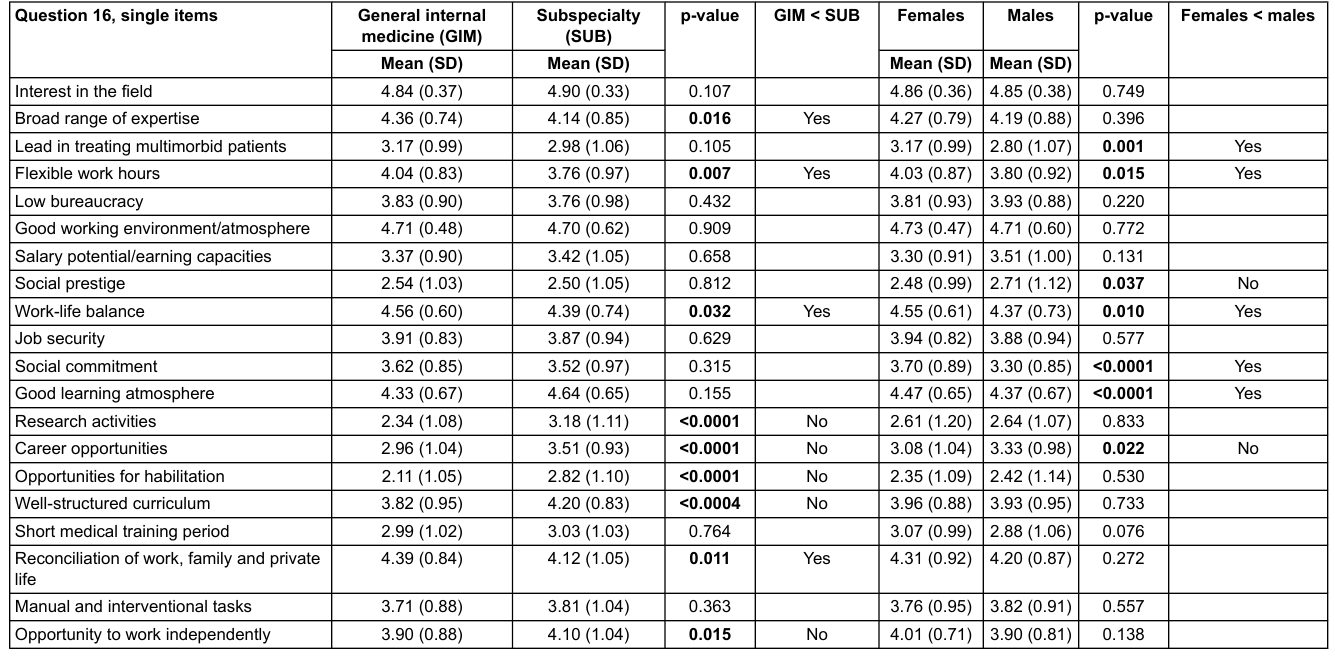
Table 2: Criteria for the choice of medical specialty by medical qualification aimed for (n = 339) and by gender (n = 392). Each criterion was rated on a scale from 1 “not impor- tant,” to 3 “neutral,” to 5 “very important.” The table shows mean scores, standard deviations (SD), and the p-value by the covariates reported. Question 16, single